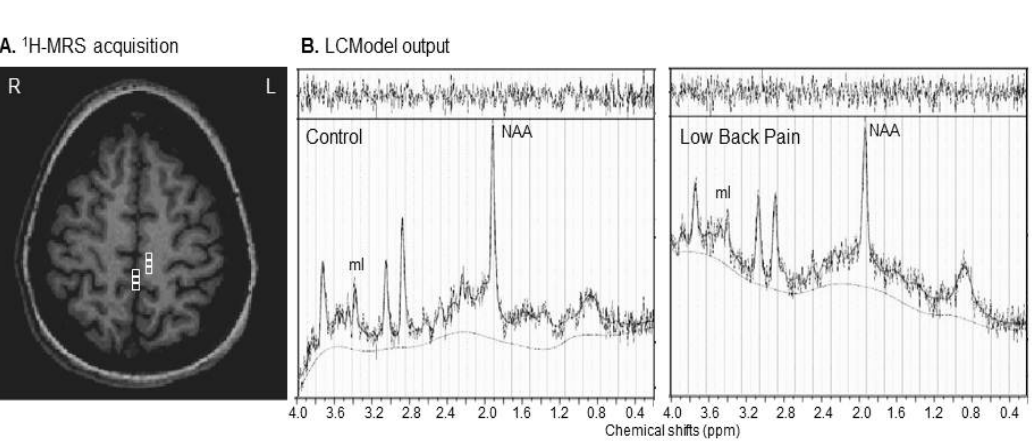
Figure 1. ( A ) Magnetic resonance spectroscopy acquisition: white squares represent the ( B ) LCModel output showing N -acetylaspartate (NAA) and myo-inositol (mI) peaks from right M1 in one representative control and low back pain subject. Lower NAA (8.5 mM vs . 9.8 mM) is visible in patient compared to control; ppm, parts per million; R, right; L,